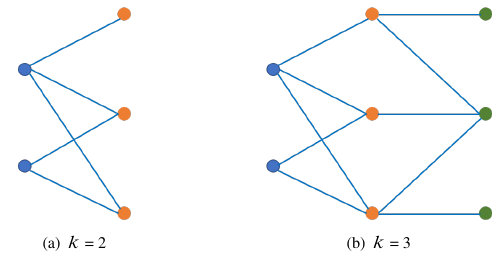
Fig. 1 Examples of multipartite graph with different k